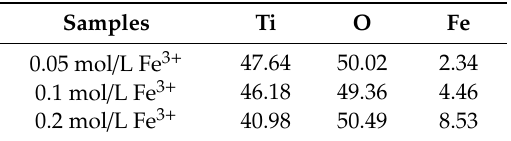
Figure 2. Typical SEM images of ( a ) pure TiO 2 nanotube arrays without doping, ( b ) Fe 3 + doped TiO 2 NTAs, ( c ) cross section of Fe 3 + doped TiO 2 NTAs, and ( d ) EDS spectrum of 0.2 mol / L Fe 3 + doped TiO 2 NTAs. Table 1. Weight ratios of Ti, O, and Fe in Fe 3 + doped TiO 2 nanotubes arrays (NTAs) with di ff erent doping concentrations.